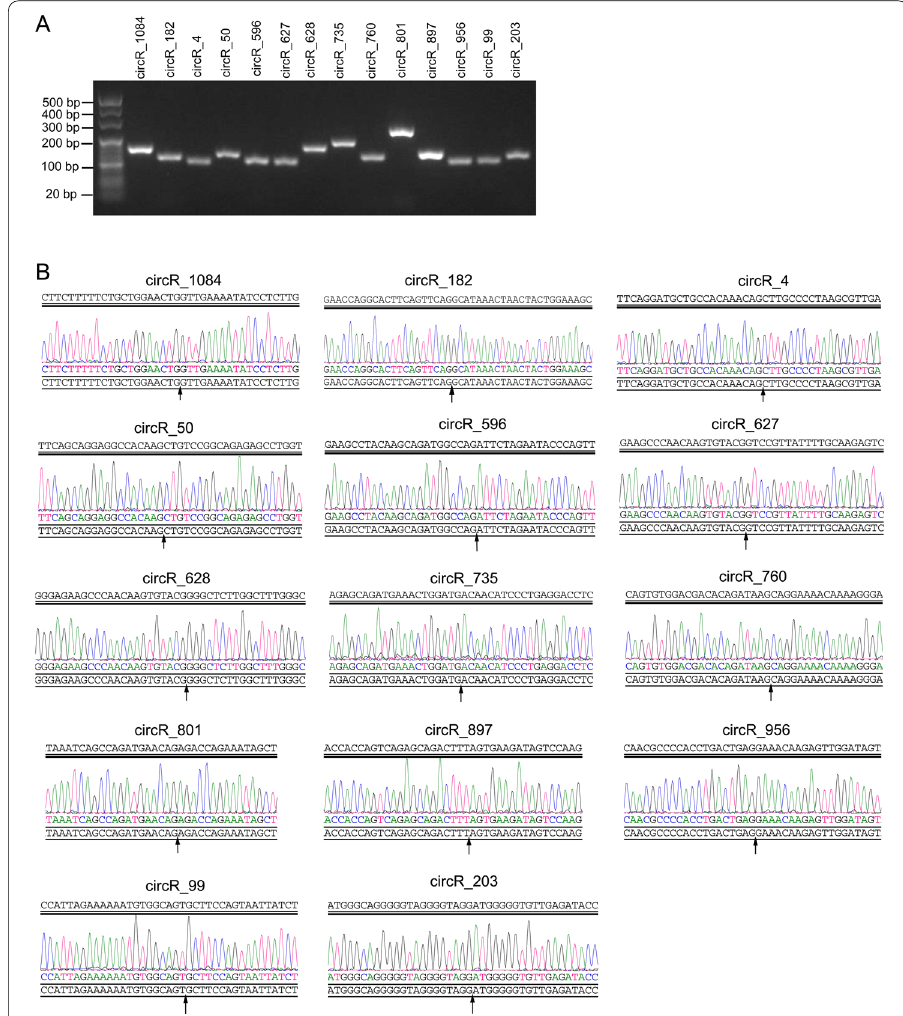
Fig. 3 Results of agarose gel electrophoresis analysis and DNA sequence of polymerase chain reaction (PCR) amplification products. A Agarose gel electrophoresis analysis showed the length of PCR amplification products. Lane 1 is the DNA marker. B Sequence around the splice junction verified by DNA sequencing. Black arrows indicate the splice junction of circular RNAs